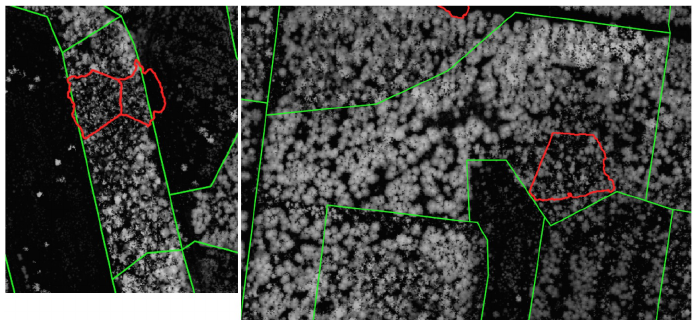
Figure 8. Forest compartment borders are marked with a green line, while structurally different microstands within a compartment with red. Background layer: LiDAR-based